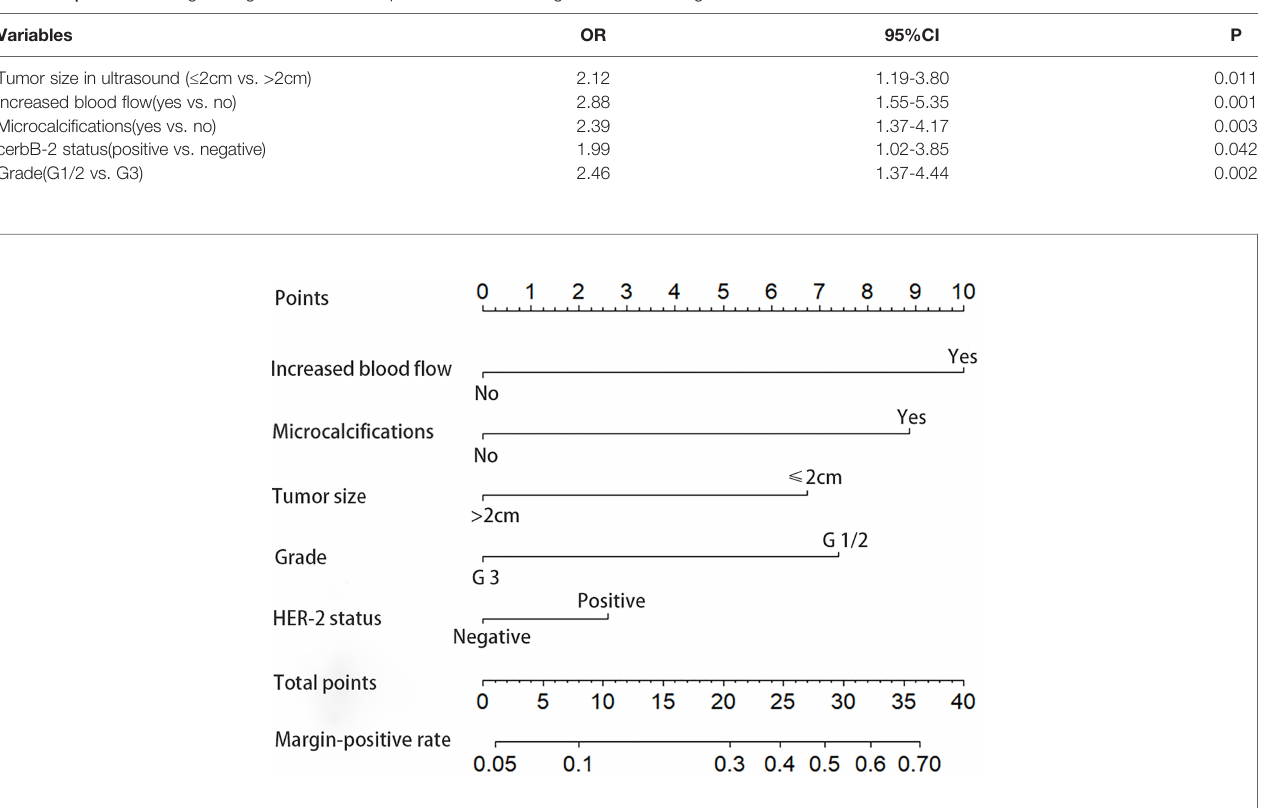
FIGURE 1 | Nomogram for predicting positive resection margins in breast-conserving surgery.